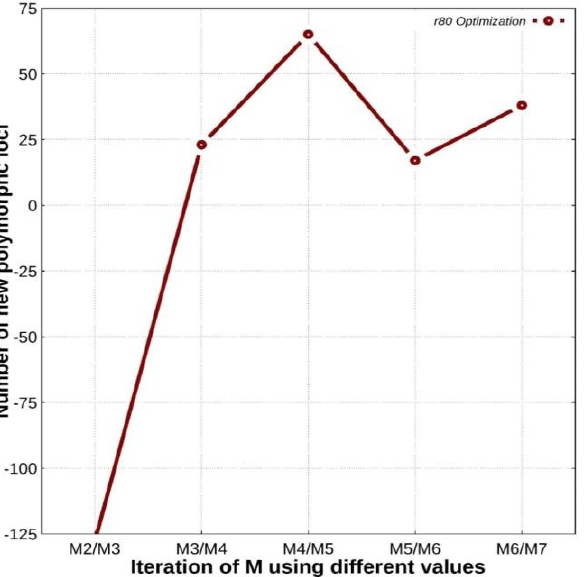
Figure 2. Plot of the number of new polymorphic loci (r80 loci) added on each iteration of “M” and “n” for datasets versus iterations of “M” using different